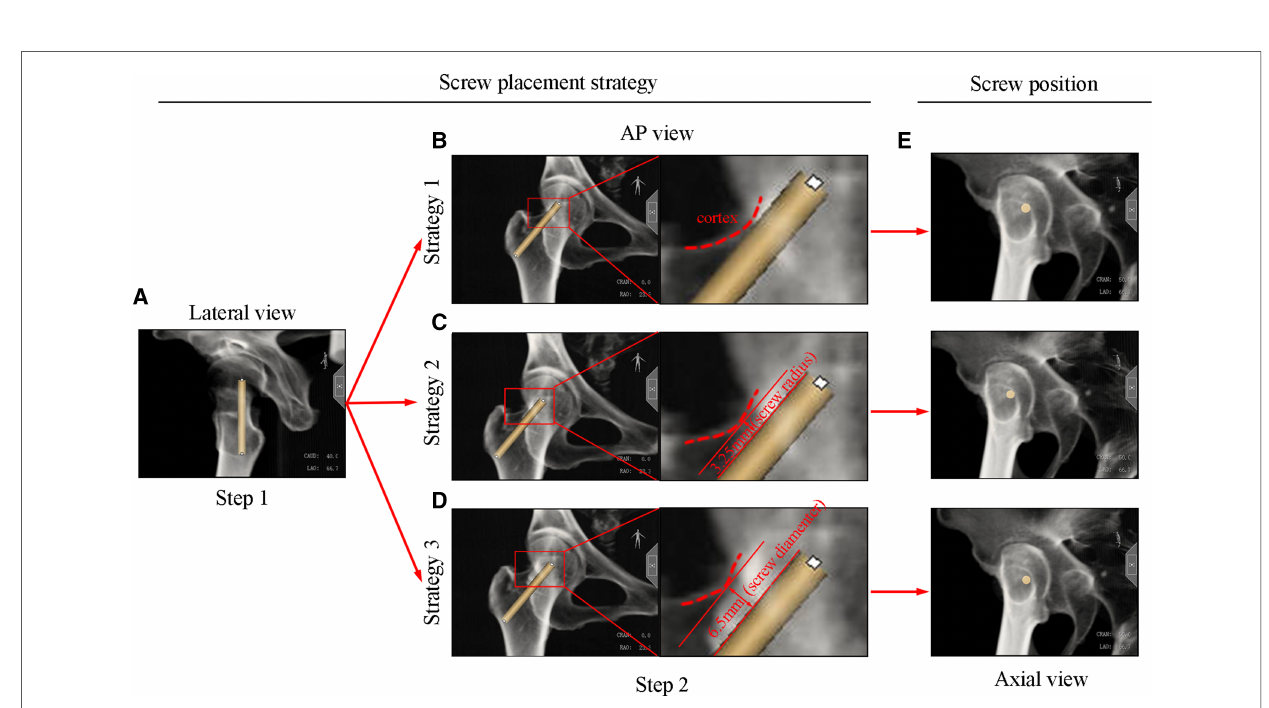
FIGURE 3 Three screw placement strategies and corresponding axis